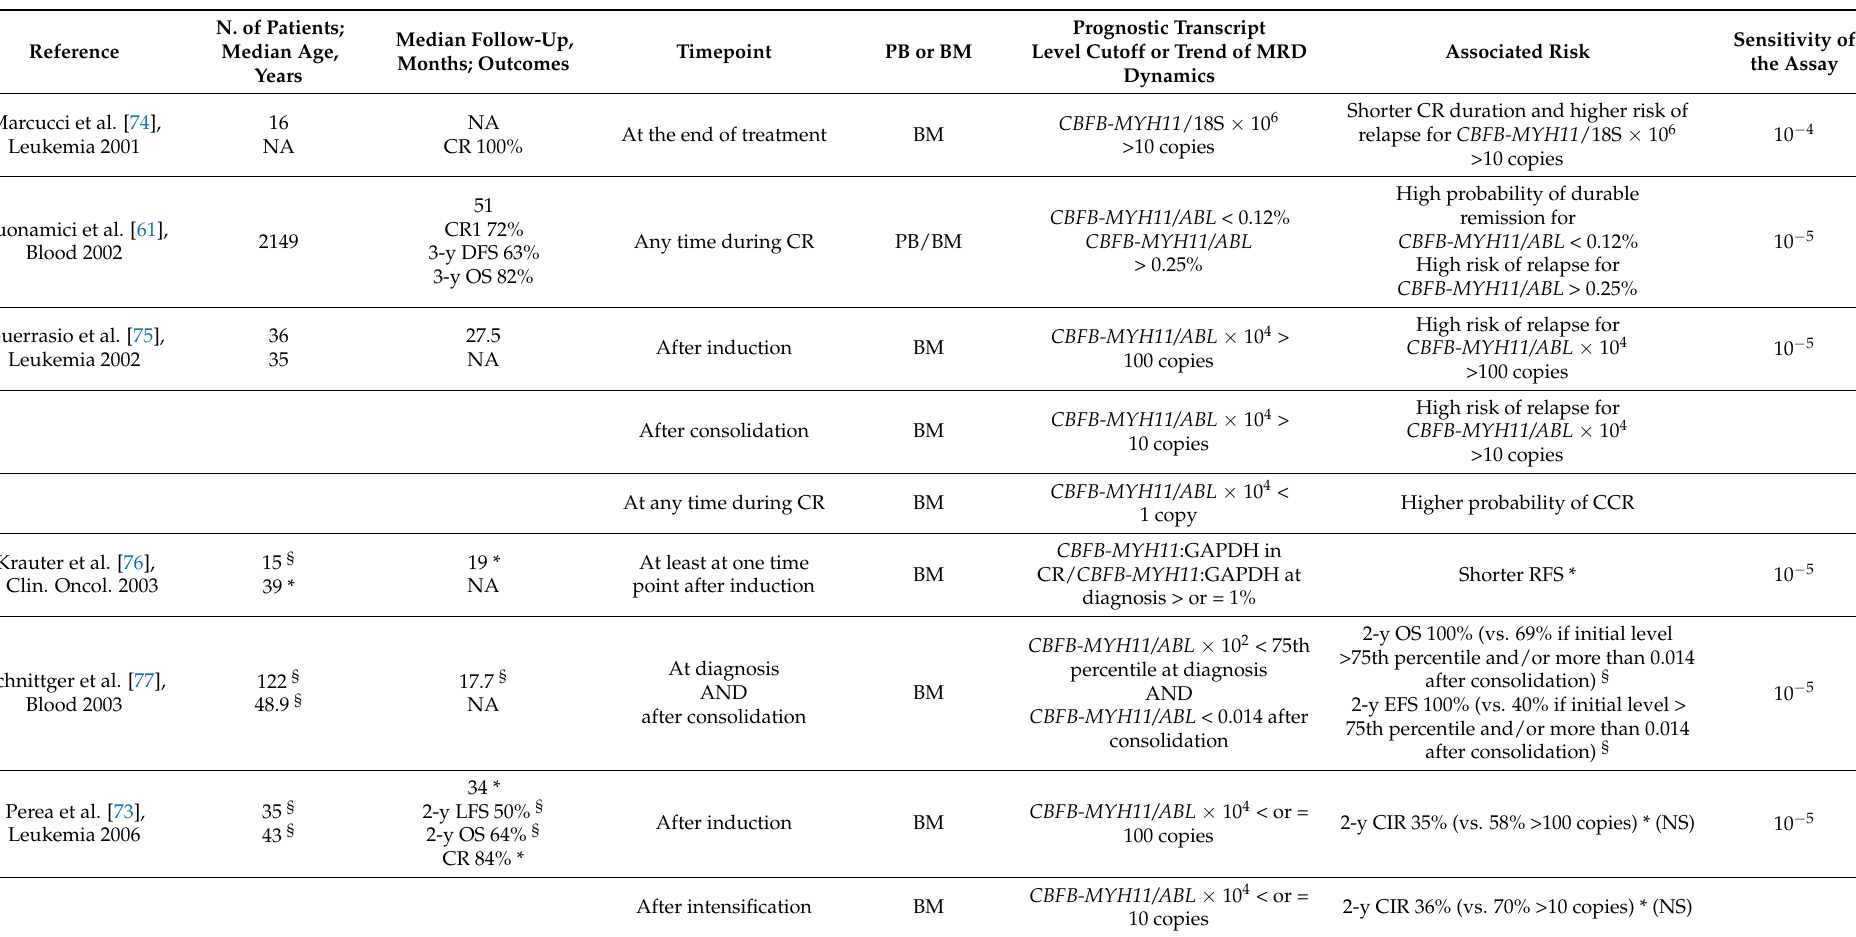
Table 3. Molecular MRD monitoring in AML with CBFB-MYH11 fusion